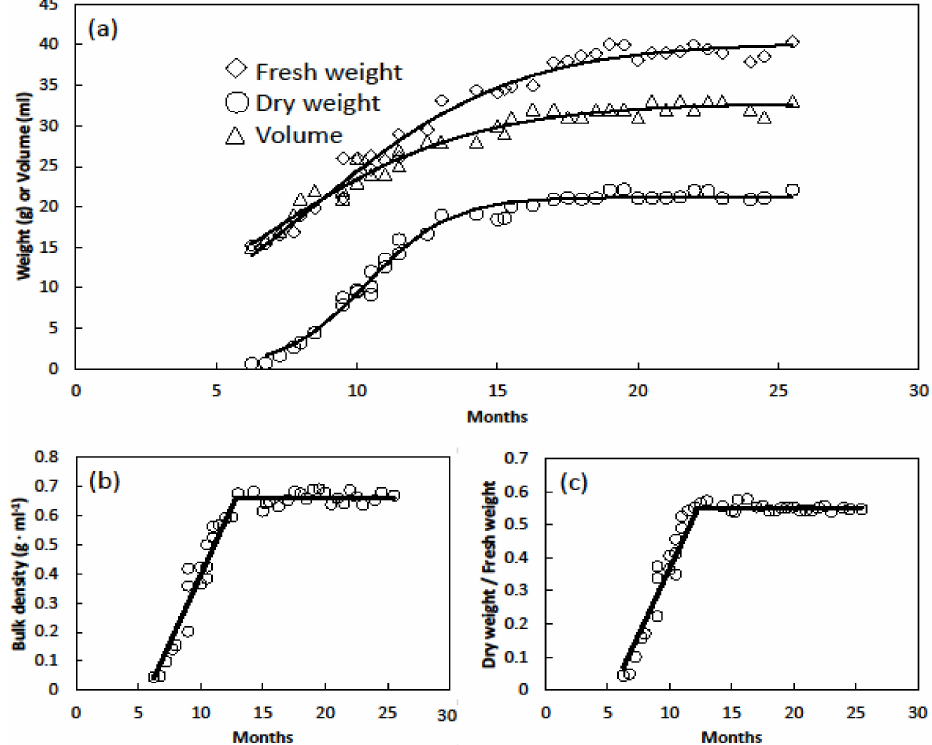
Figure 3. Weight and volume relationships of Cycas micronesica seed gametophytes from 6 to 26 months in age. ( a ) Fresh weight: y = 40.313 / (1 + exp(2.382 − 0.280x)), p ≤ 0.001, r 2 = 0.98, dry weight: y = 21.175 / (1 + exp(7.046 − 0.680x)), p ≤ 0.001, r 2 = 0.98 or volume: y = 32.856 / (1 + exp(1.848 − 0.276x)), p ≤ 0.001, r 2 = 0.97; ( b ) Bulk density: if x = 6.2–12.9 then y = − 0.55 + 0.09x, p ≤ 0. 001, r 2 = 0.92, if x = 12.9–25.5 then y = 0.66; ( c ) The quotient dry / fresh weight: if x = 6.2–12.3 then y = − 0.43 + 0.08x, p ≤ 0.001, r 2 = 0.89, if x = 12.3–25.5 then y =